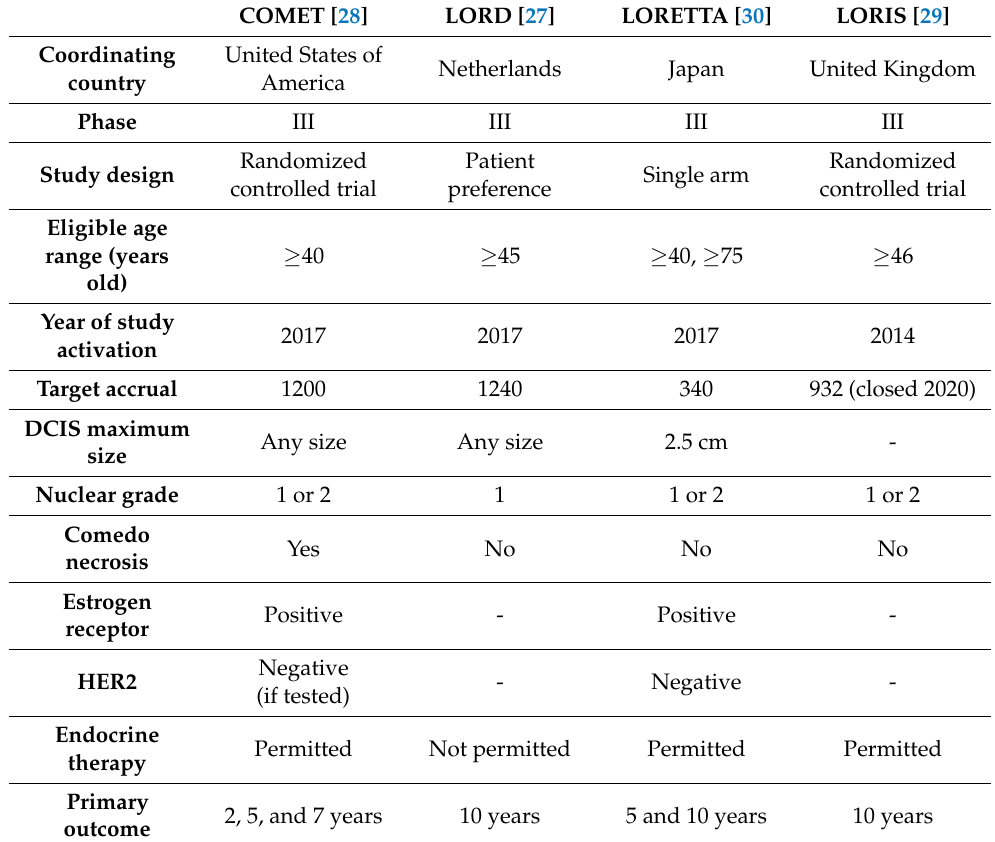
Table 1. Summary of international clinical trials evaluating active image-based surveillance for patients with low-risk